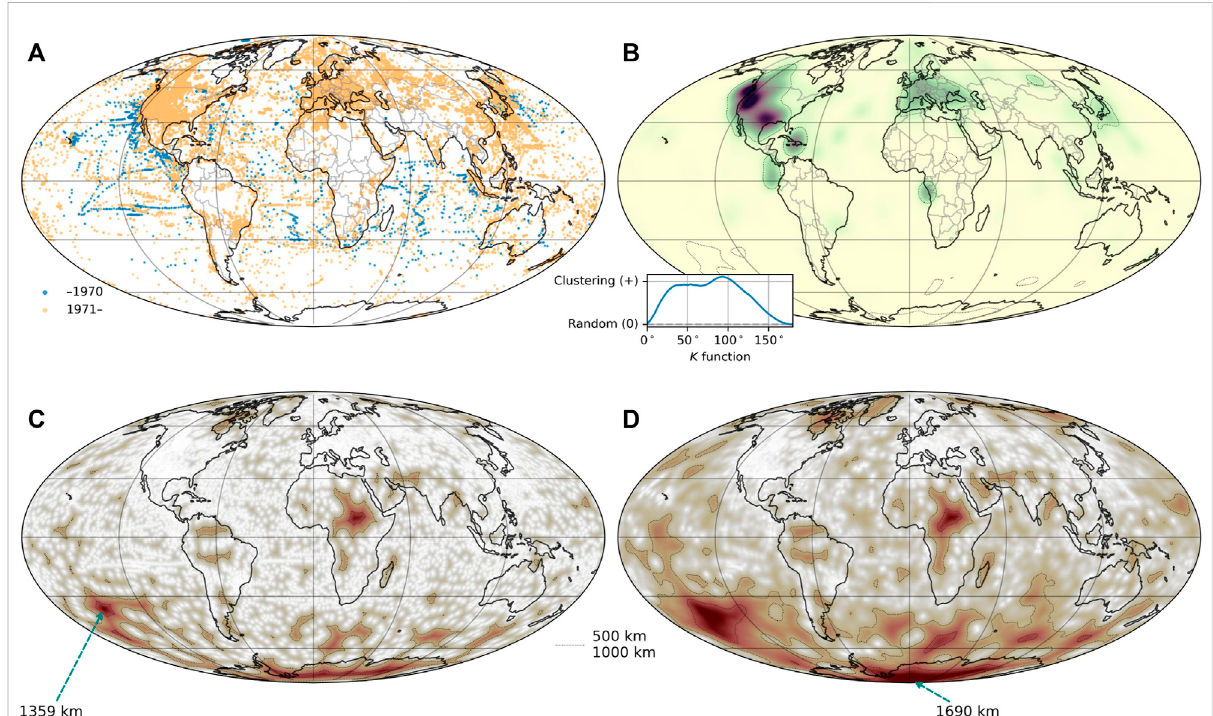
FIGURE 1 Geographic distribution of heat fl ow measurements. (A) Measurements in IHFC, color coded by year of measurement. (B) Kernel density estimation(KDE)for density ofheat fl owmeasurements, using great circle distances and aGaussian kernel with σ = 400 km. Adotted contour marks the 5% percentile. Inset shows the centred Ripley ’ s K function plot, where the positive values indicate that measurements are heavily clustered on all scales, with a peak at 90 ° . (C) Distance to the nearest measurement. The longest distance is 1359 km, at 37 ° S 148 ° W in the South Paci fi c Ocean. (D) Mean distance to nearesttenmeasurements.Thelongestdistanceis1690 km,at85 ° S8 ° EinEastAntarctica.Contours indicate 500and1000 km distances in (C) and (D) . Maps are displayed with perceptually linear colour representation (Crameri and Shephard, 2019; Morse et al., 2019) using matplotlib (Hunter,